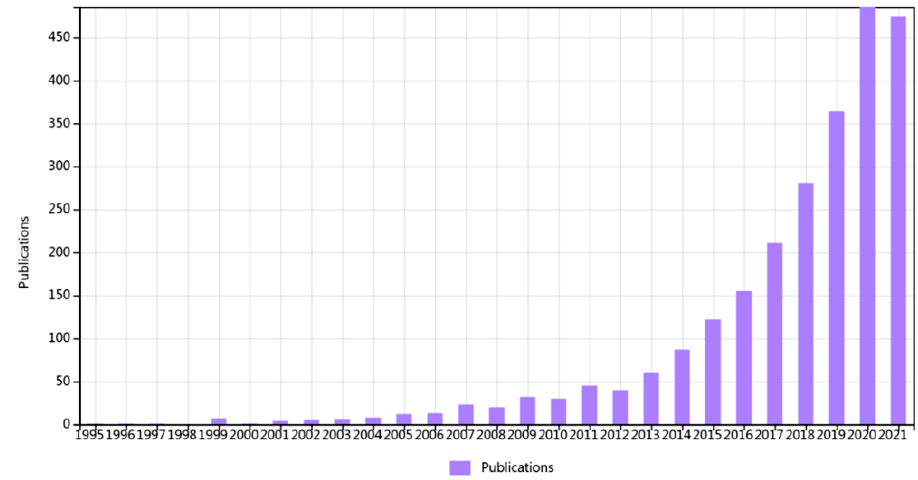
Figure 1. Number of publications over the years.